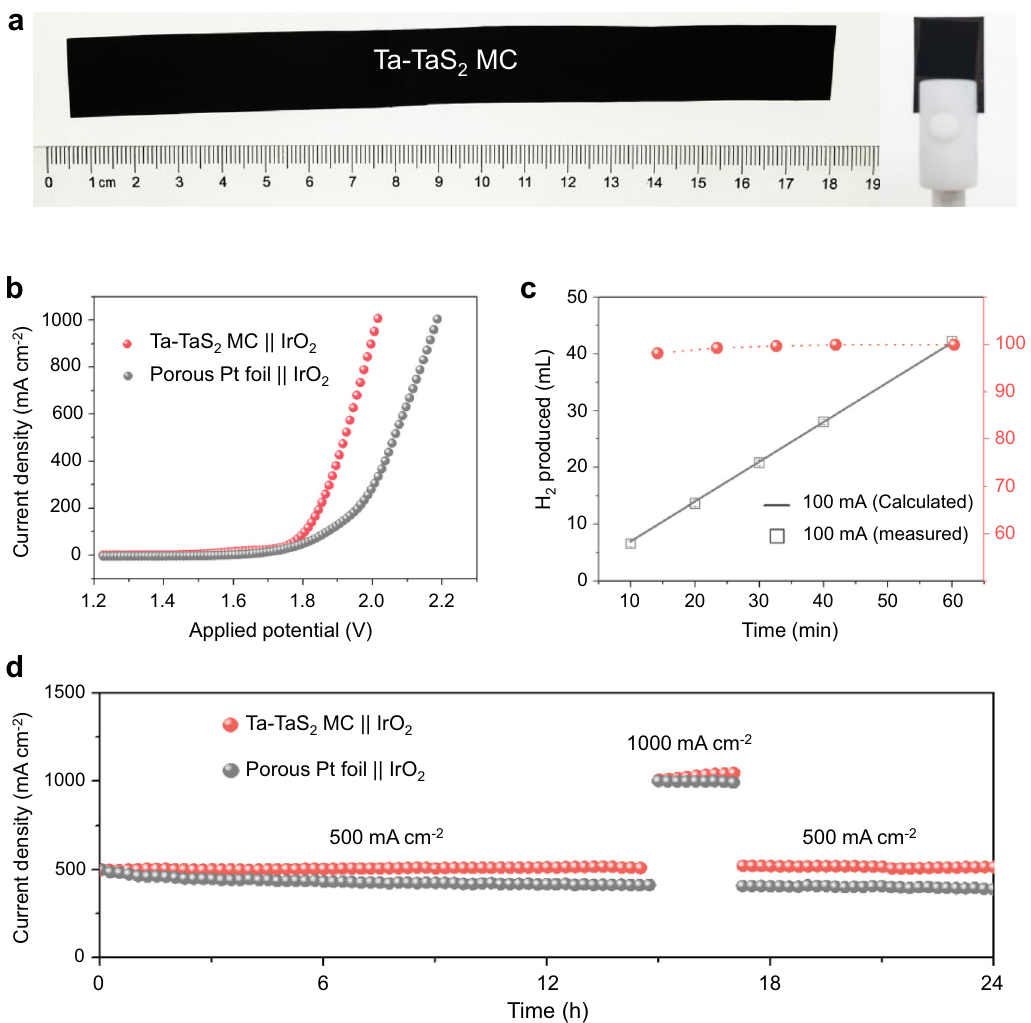
Fig. 5 Scalable synthesis of the Ta-TaS 2 MC for PEM water electrolysis. a A photograph of Ta-TaS 2 , about 175 × 20 mm, and corresponding self- supporting electrode. b V-I curves of overall water electrolysis with the Ta-TaS 2 MC as the cathode and IrO 2 as the anode and the current density reaches 1000 mA cm − 2 . The porous Pt foil ‖ IrO 2 were also shown for comparison. c Experimental and theoretical amounts of H 2 generated by the Ta-TaS 2 electrode at a fi xed current density of 100 mA cm − 2 and corresponding Faraday ef fi ciency. d Long-term tests of water electrolysis with Ta-TaS 2 or porous Pt foil as the cathodes, and commercial IrO 2 as the